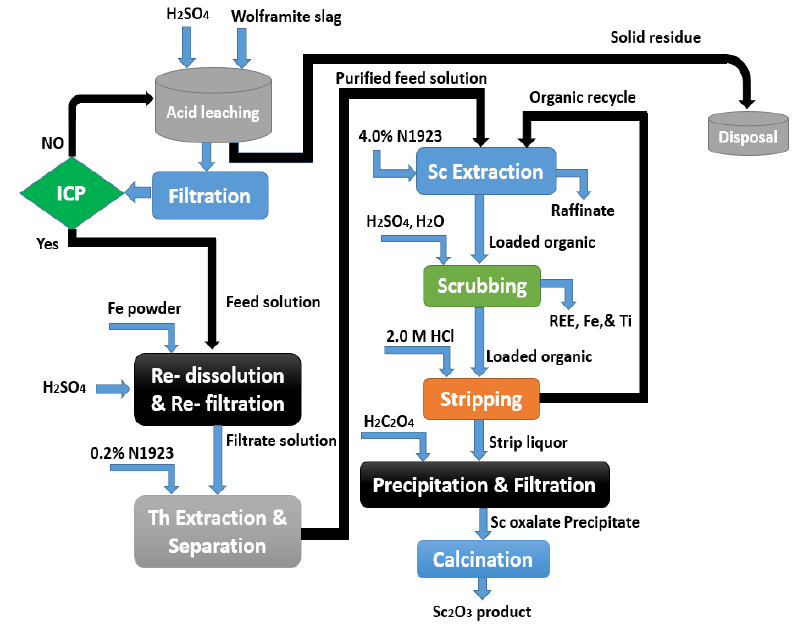
Figure 12. Scandium recovery from tungsten slag, adapted from [117].